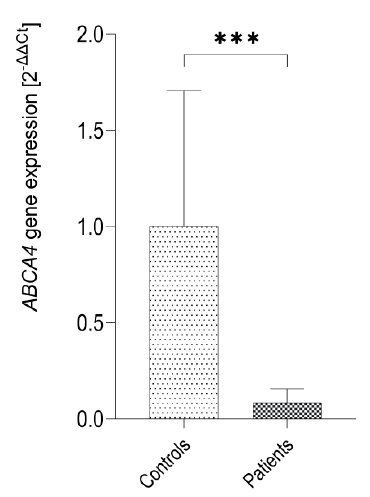
Figure 4. Expression of the ABCA4 gene in hair follicles (HF) of patients with Stargardt disease ( n = 3) and healthy controls ( n = 8) as measured by qRT-PCR for TaqMan probe Hs00979586_m1 ( ABCA4 exons 35–36). ∗∗∗ , p = 0.0001 as evaluated by Mann-Whitney U test.